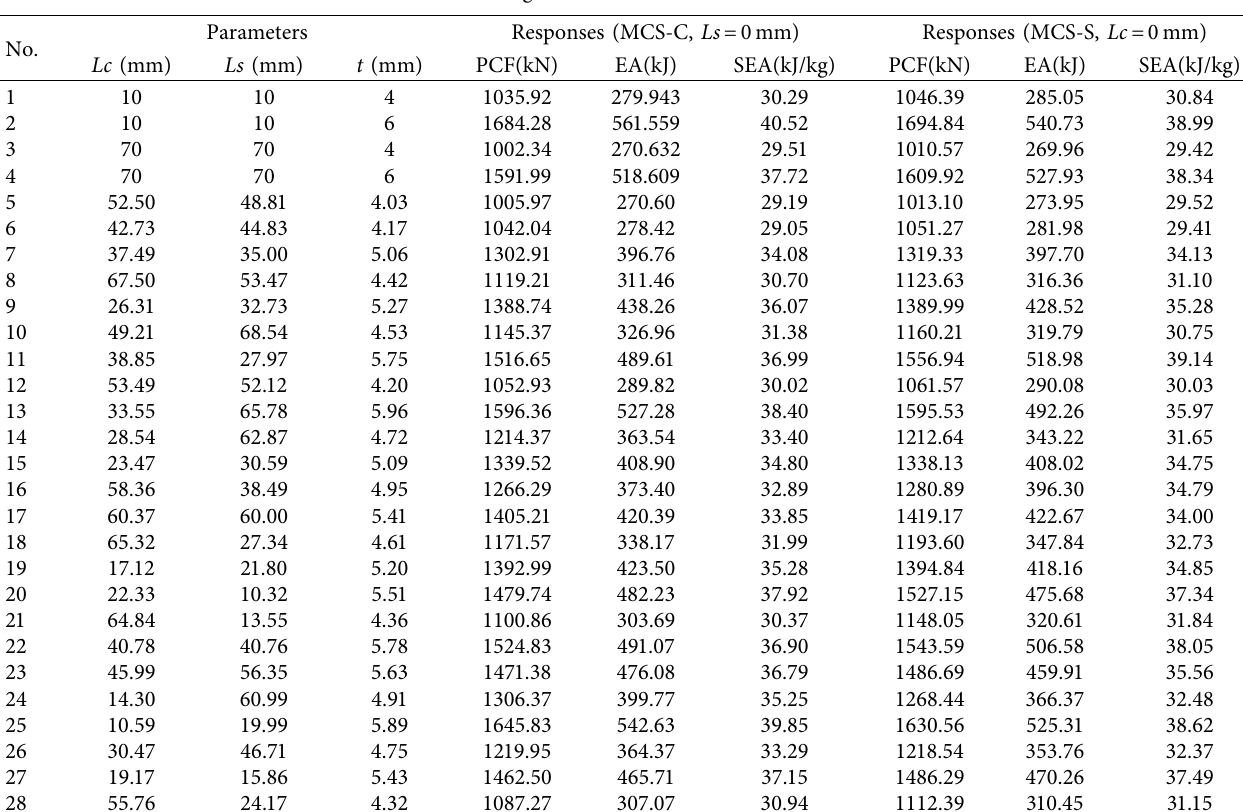
Table 4: Design matrixes of MCS-C and MCS-S.